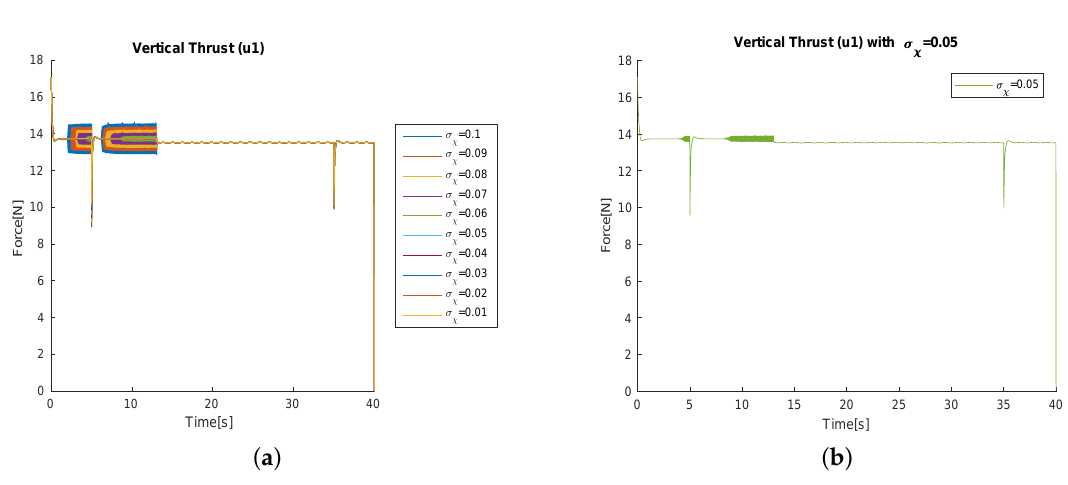
Figure 23. ( a ) Vertical Thrust with distinct σ χ ’s; ( b ) Vertical Thrust with σ χ = 0.05.